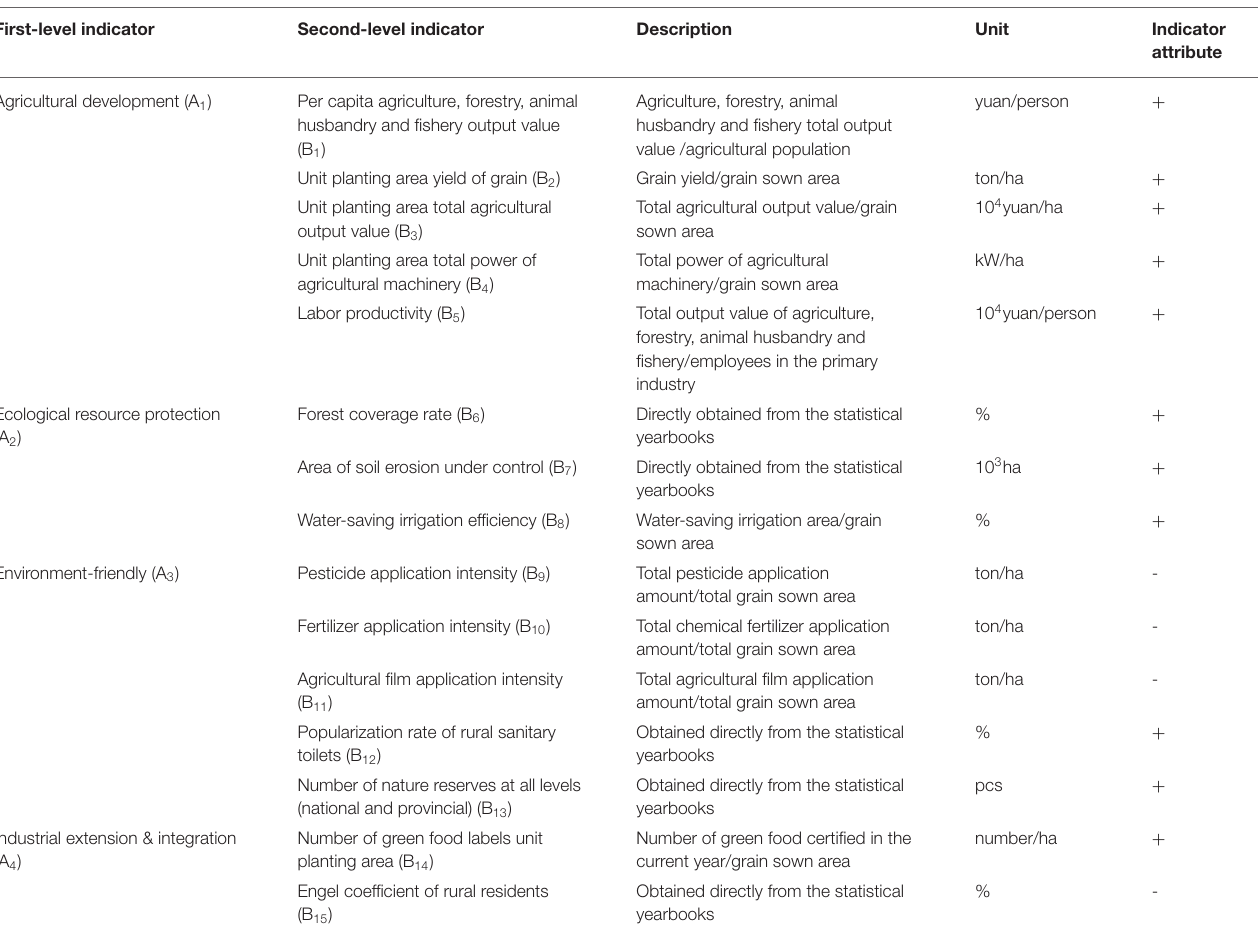
TABLE 2 | Evaluation index system of agricultural green development